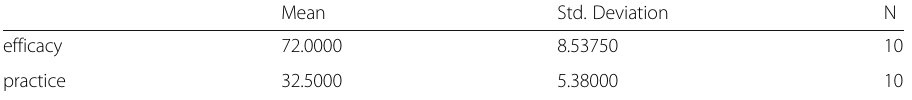
Table 3 Descriptive Statistics for ELT Teachers ’ Self-efficacy and Instructional